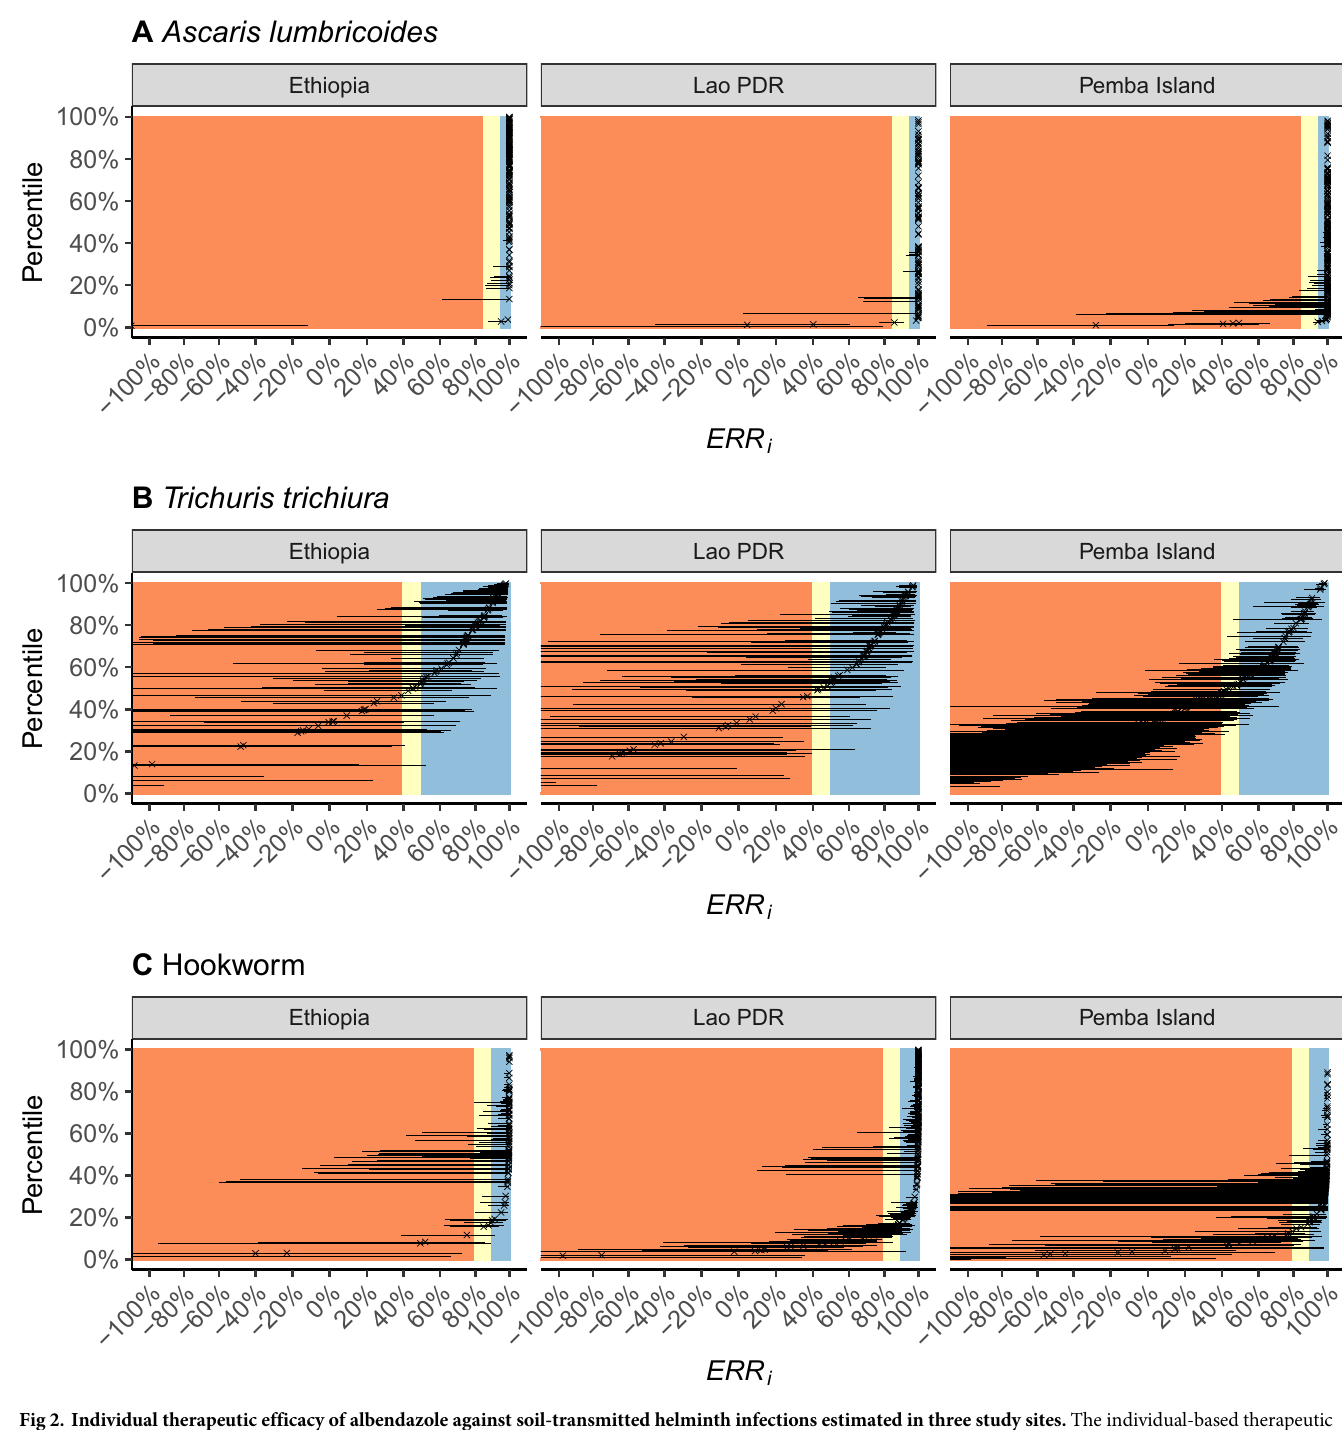
Fig 2. Individual therapeutic efficacy of albendazole against soil-transmitted helminth infections estimated in three study sites. The individual-based therapeutic efficacy is expressed as the reduction in fecal egg counts (FECs) following drug administration (egg reduction rate, ERR i ) and was estimated by fitting the Bayesian model [15,16,21]to FEC data on Ascaris lumbricoides ( panel A ), Trichuris trichiura ( panel B ) and hookworm ( panel C ) collected before and after administration of a single 400 mg oral dose of albendazole in three study sites, Ethiopia, Lao PDR and Pemba Island (Tanzania). Each cross denotes the posterior median of ERR horizontal lines denote 95% credible intervals. The estimates are ordered according to the percentile of the estimated median ERR i . The areas shaded in orange, yellow and blue denote, respectively, the World Health Organization categories for ‘reduced’, ‘doubtful’ and ‘satisfactory’ population-based therapeutic efficacy ( ERR differ for each infection). Negative estimates of ERR i correspond to FECs that increased after administration of